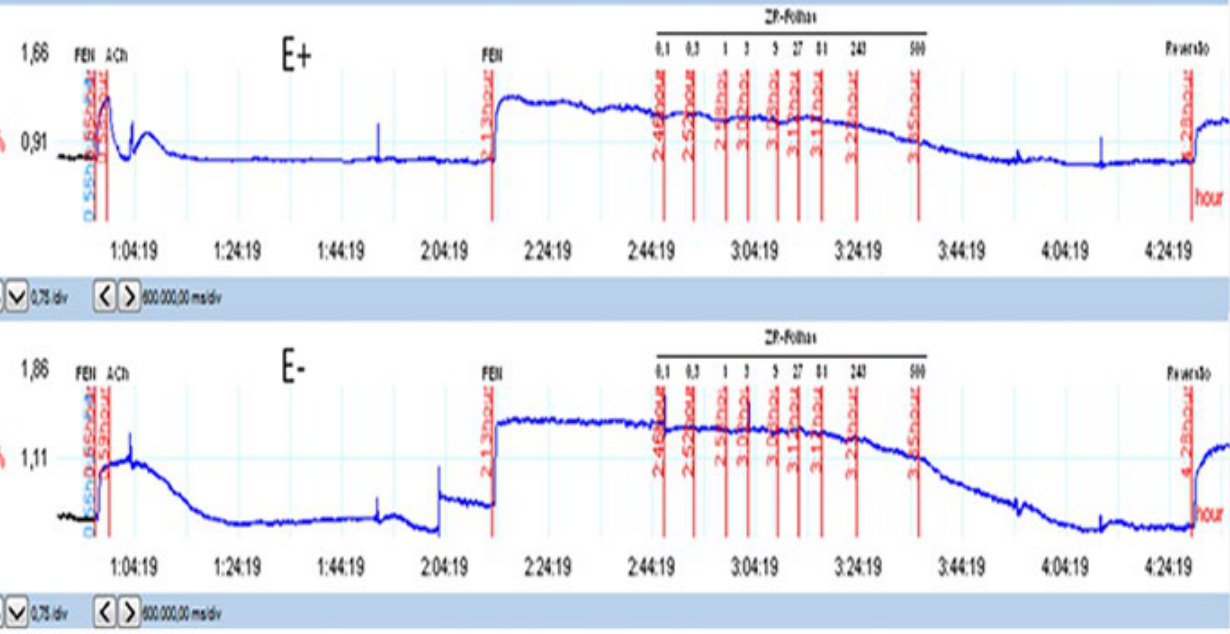
FIGURE 3 - Original tracing of the vasorelaxant effect of EEtOH-Zr/leaves on contractions induced by phenylephrine (10 μM) in presence (E+) or absence of vascular endothelium